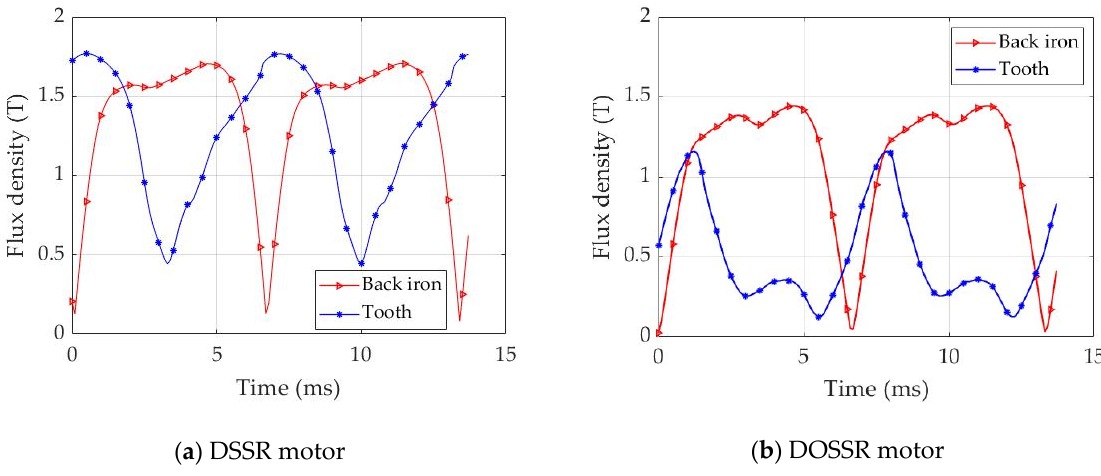
Figure 11. Flux density for the DSSR motor and the DOSSR motor (100 A rms, 900 rpm).